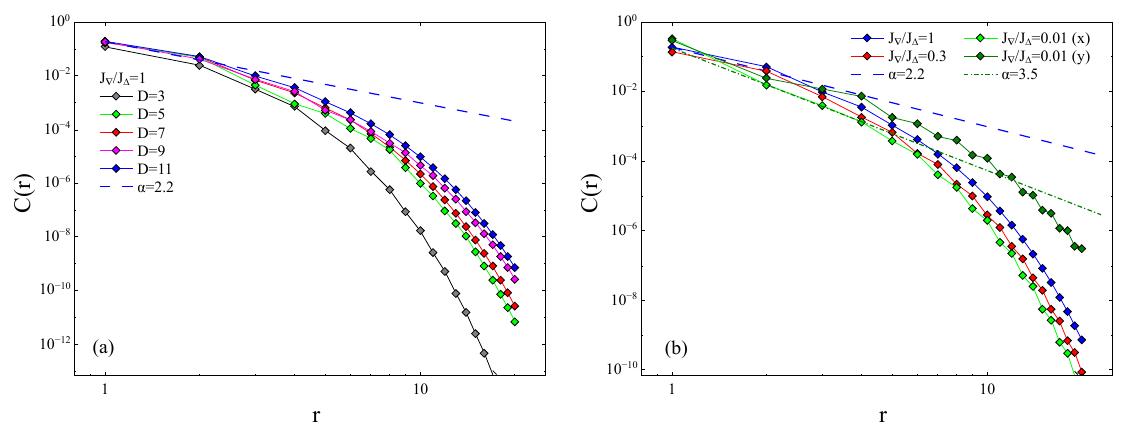
Figure 7: (Color online) Log-log plot of the long range spin-spin correlations 〉 obtained with PESS (a) at the isotropic point, J C ( r ) = 〈 S ( . S ( x , y ) x + r , y ) different D and (b), the C ( r ) for PESS ( D = 11) in the nematic phase at large breath- ing anisotropy J (cid:53) / J (cid:52) = 0.01 compared with those of the QSL phase at J (cid:53) / J (cid:52) = 0.3 and 1. All correlations show approximate power-law decays, C ( r ) ∼ C by straight dashed lines. A similar decay up to 7 or 8 lattice spacings is observed in the QSL phase and along the chain of the nematic phase, with an exponent α (cid:39) 2.2. The green dashed line shows the power-law fit in the nematic phase, perpendicular to the chains, with α (cid:39)